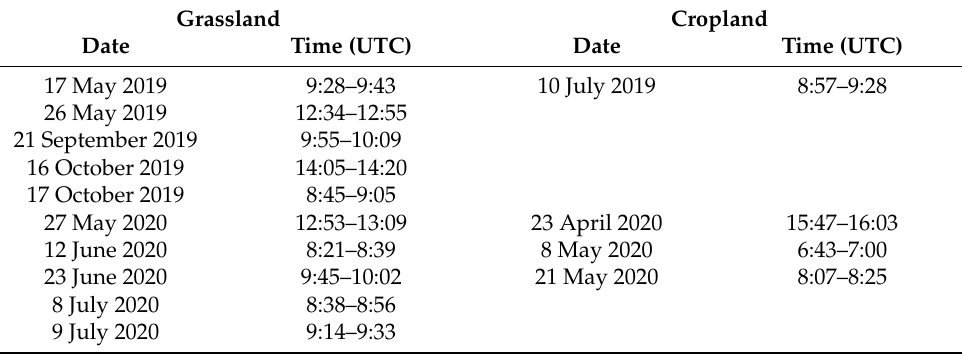
Table 3. List of flight missions: date and time interval in UTC at the grassland (site: Bugac) and the cropland (site: